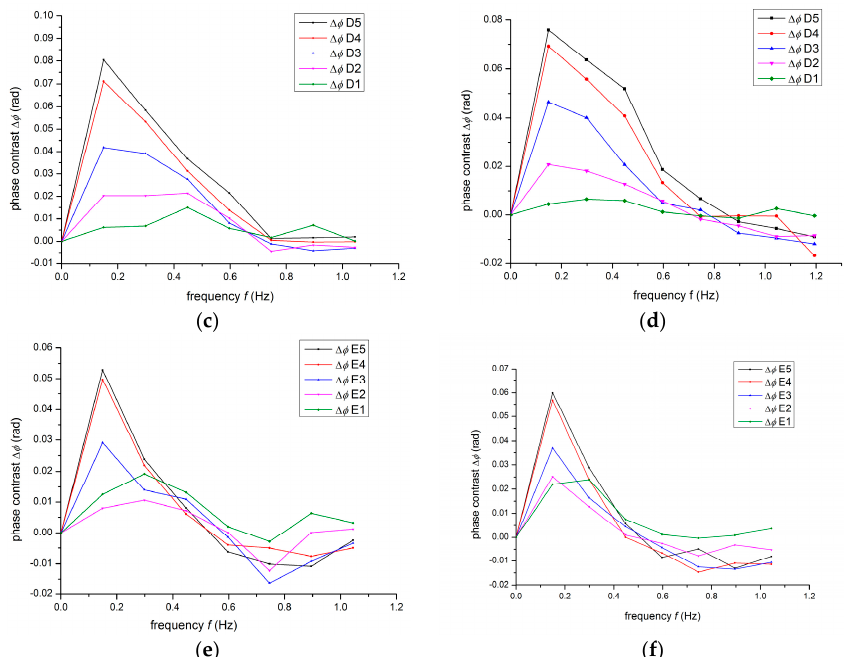
Figure 11. Phase contrast profiles for: ( a , b ) the defects of Series C (0.6 mm); ( c , d ) the defects of Series D (0.8 mm); and ( e , f ) the defects of Series E (1 mm). The left side plots correspond to the phase contrasts calculated through the aid of the top left sound area and the right plots correspond to the phase contrasts selecting the entire surface as a sound area.